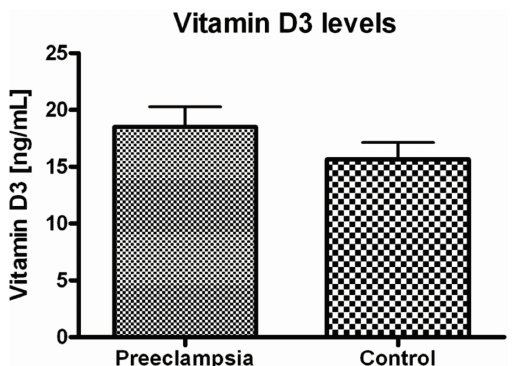
Figure 2. Vitamin D 3 (25(OH)D 3 ) plasma levels in preeclamptic women vs. control. No significant difference between groups was found.